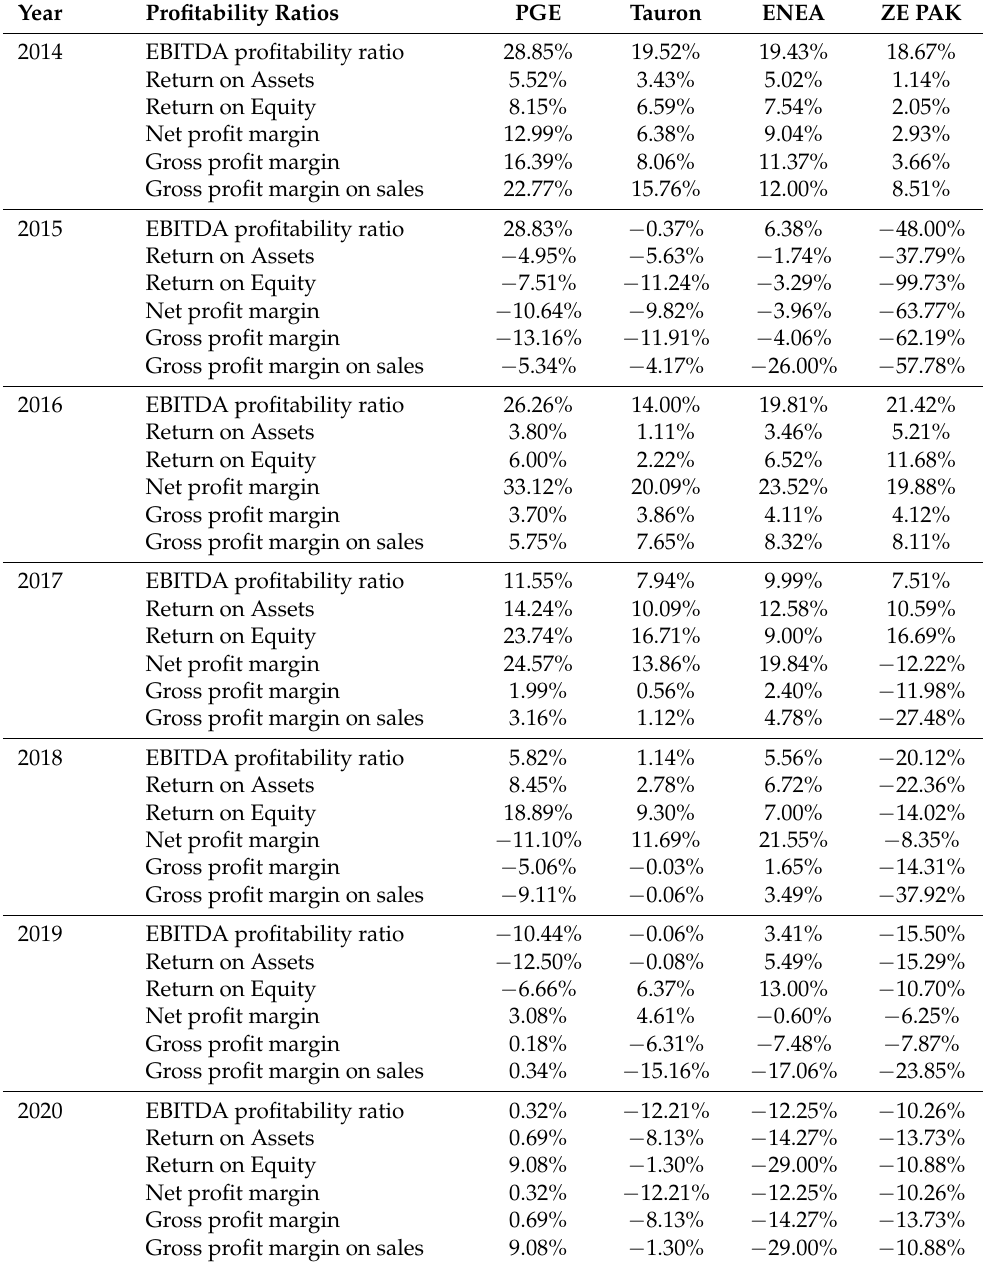
Table 18. Profitability ratios of capital groups from 2014 to